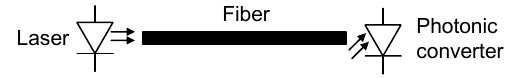
Figure 1. Basic principle of power over fiber.